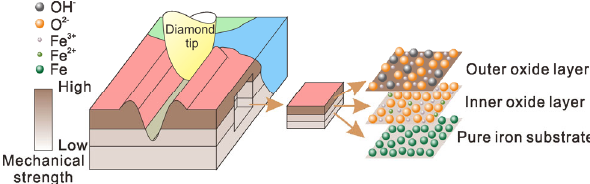
Fig. 8 Schematic illustration demonstrating the effect of the oxide film on nanoscale mechanical removal of pure iron.